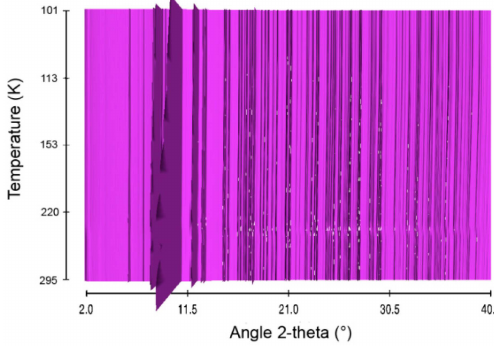
Figure 3. Sequential plot of the diffraction patterns of HB within the range of temperature 101–295